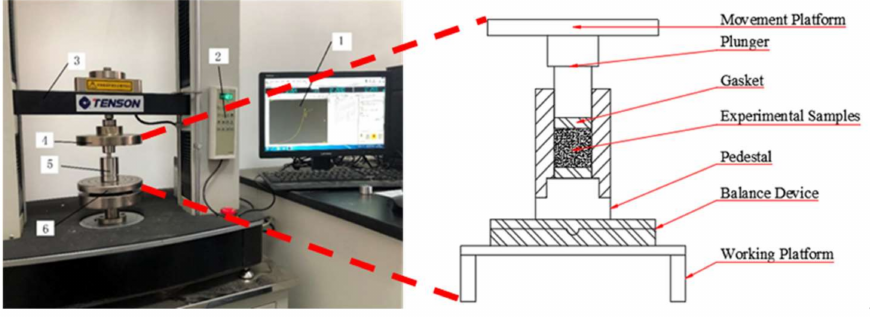
Figure 1. Schematic illustration of pelleting, 1; Computer, 2; Control bar, 3 and 4; Movement platform, 5; Pelleting unit, 6; Balance